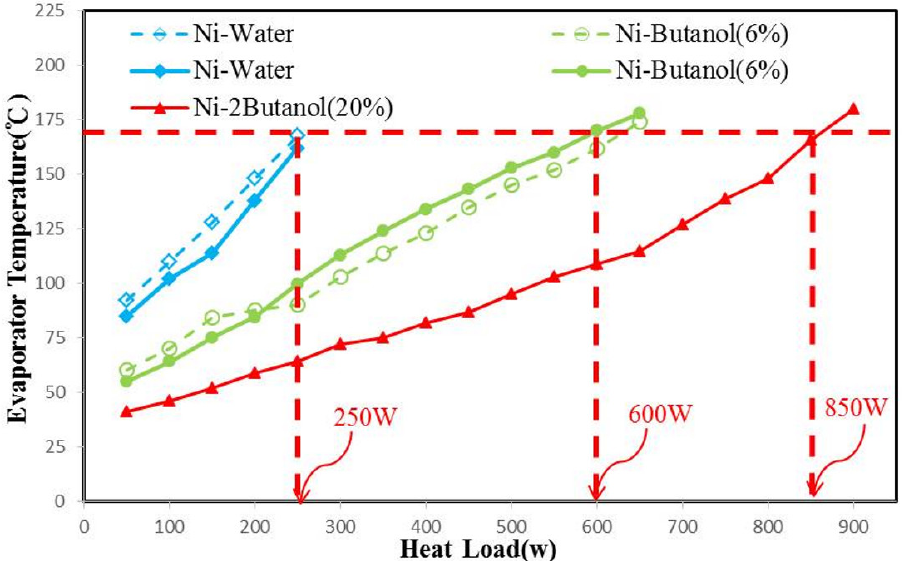
Figure 8. Evaporator temperature as a function of heat load for three different test samples [10].